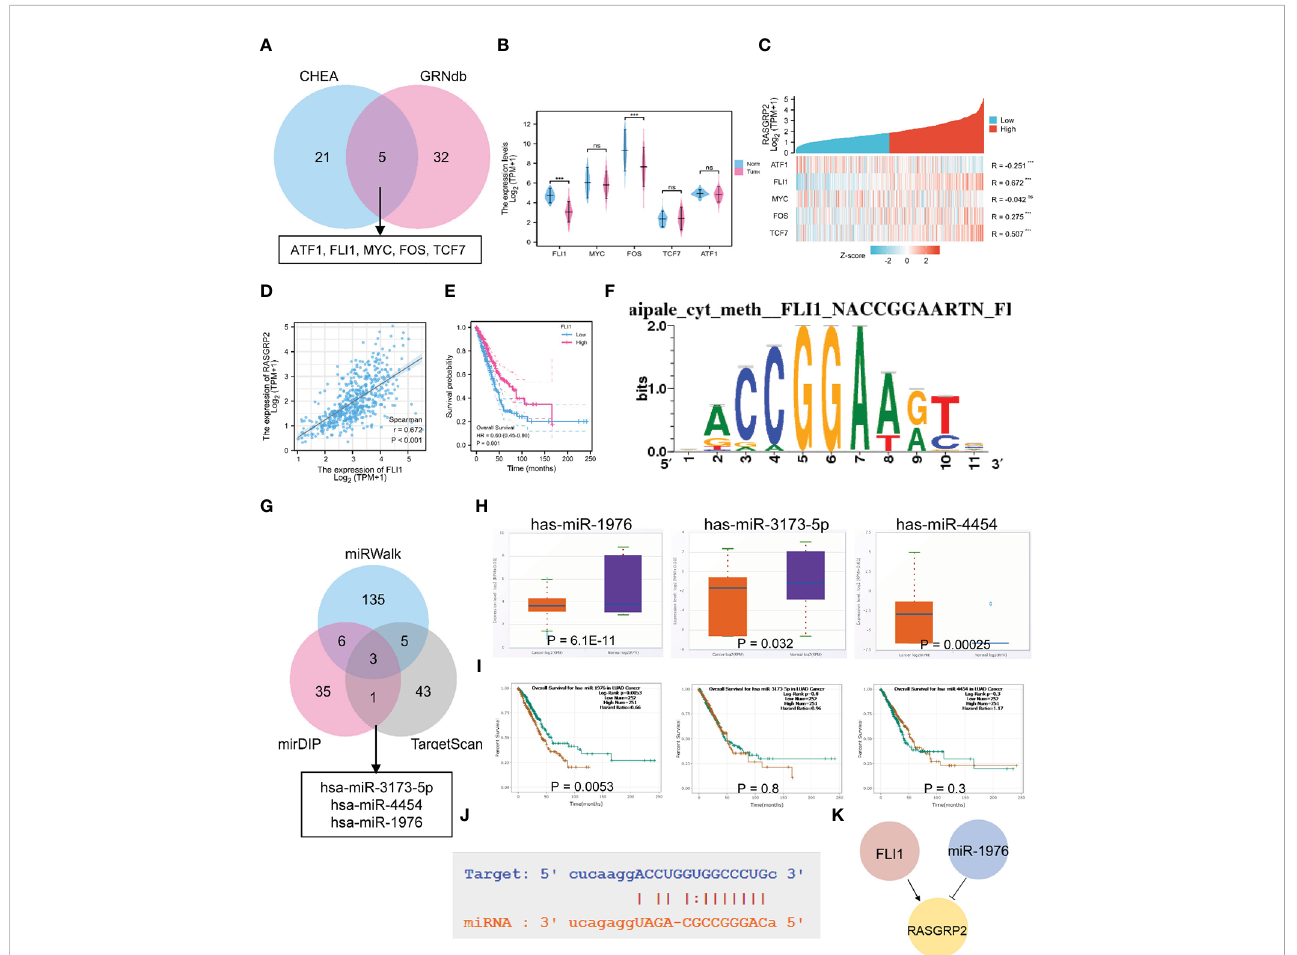
FIGURE 5 The TF-miRNA-mRNA regulatory network of RASGRP2. (A) Venn diagram found that ATF1, FLI1, MYC, FOS and TCF7 were potential transcription factors of RASGRP2. (B) The expression levels of ATF1, FLI1, MYC, FOS and TCF in TCGA-LUAD. (C) Heatmap showed the correlation of ATF1, FLI1, MYC, FOS and TCF with RASGRP2. (D, E) Correlation scatter plot of FLI1 and RASGRP2 and its prognosis curve. (F) Predicted TF binding motif. (G) Venn diagram found that has-miR-3173-5P, has-miR-4454 and has-miR-1976 were potential miRNAs of RASGRP2. (H, I) The expression levels and prognosis curve of has-miR-3173-5P, has-miR-4454 and has-miR-1976. (J) Predicted interaction of RASGRP2 and has-miR-1976. (K) Potential upstream TF-miRNA-mRNA regulatory network of